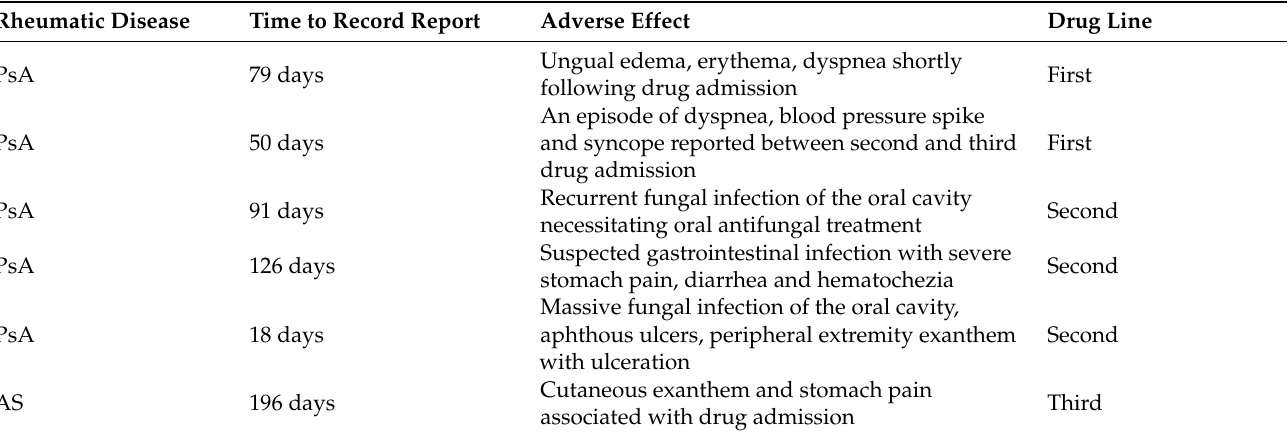
Table A1. Description and characteristics of significant adverse events necessitating drug switch for secukinumab